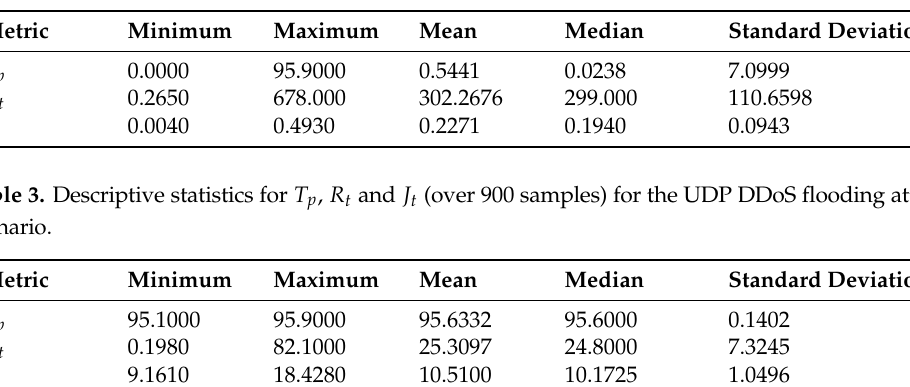
Table 2. Descriptive statistics for T p , R t and J t (over 900 samples) for the TCP DDoS flooding attack scenario.